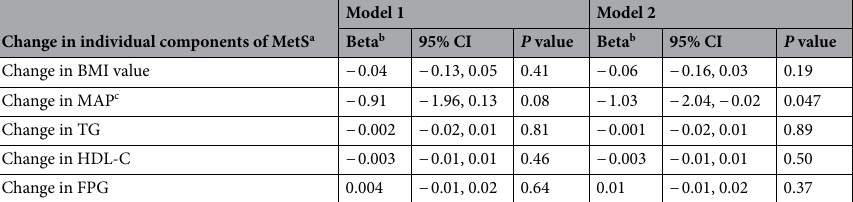
Table 2. Associations of PHQ-9 score with change in individual components of MetS. PHQ-9 the nine-item Patient Health Questionnaire, MetS metabolic syndrome, CI confidence interval, BMI body mass index, MAP mean arterial pressure, TG triglycerides, HDL-C high-density lipoprotein cholesterol, FPG fasting plasma glucose. Model 1: crude model; Model 2: adjusted for education level, marital status, smoking, alcohol consumption, tea consumption, physical activity and heart disease. A the change in individual components of MetS is calculated as the results of follow-up physical examination minus the results in the baseline. P diastolic + P systolic ) b Unstandardized regression coefficient. c MAP was calculated as MAP = ( 2 ∗